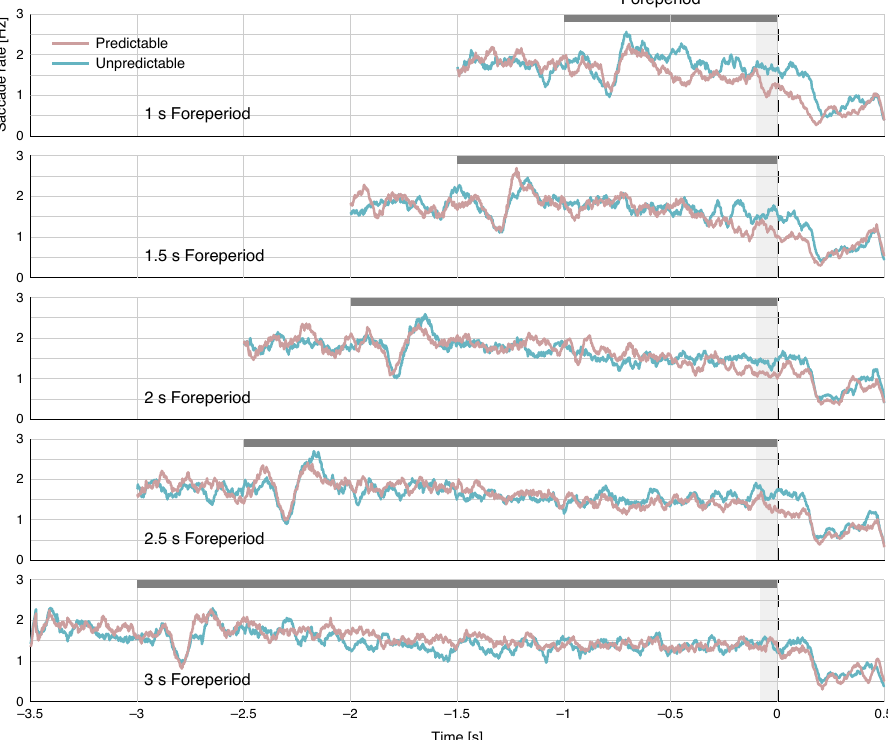
Fig. 3 Saccade rates by predictability and foreperiod. Grand average ( N = 20) saccade rate traces in the predictable (pink) and unpredictable (turquoise) conditions in each foreperiod duration. The dark gray horizontal rectangle represents the foreperiod duration. The dashed line represents target onset. The light gray shading represents the analyzed interval. Source data are provided as a Source Data fi